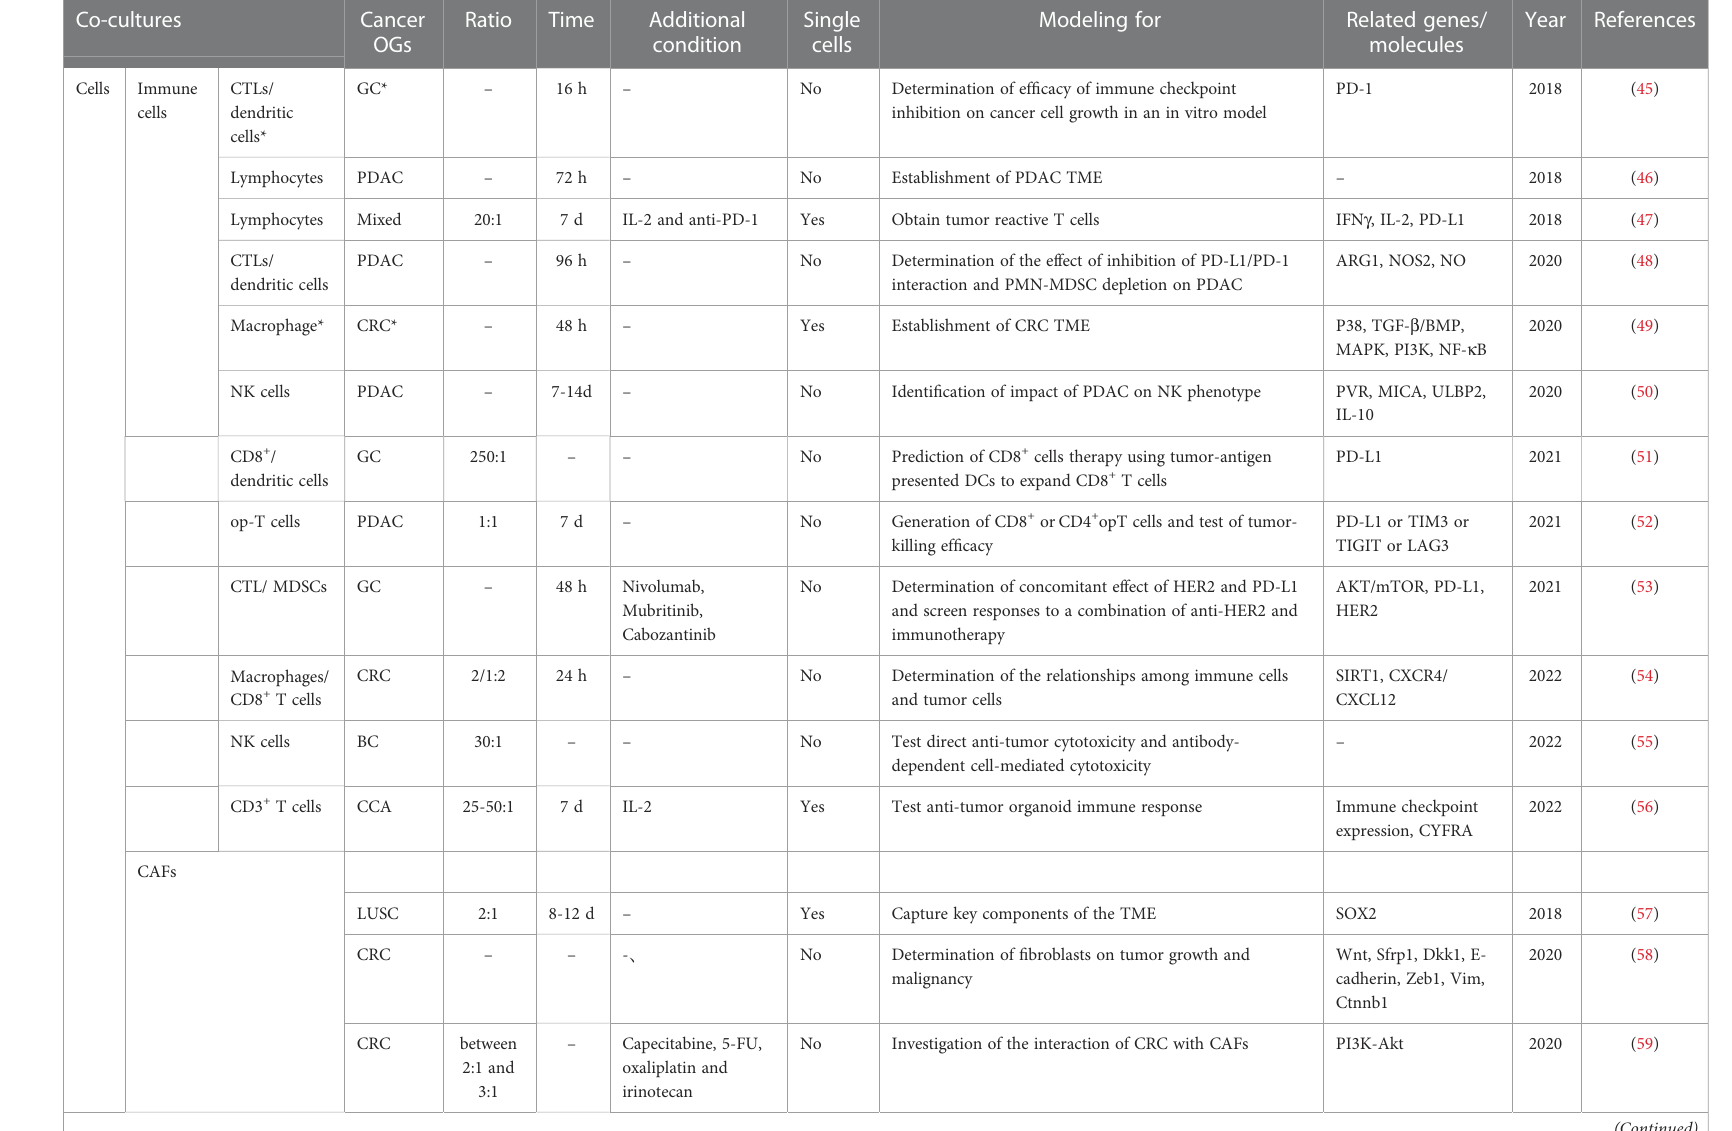
TABLE 2 Co-culture modeling systems of cancer OGs with biological subjects.